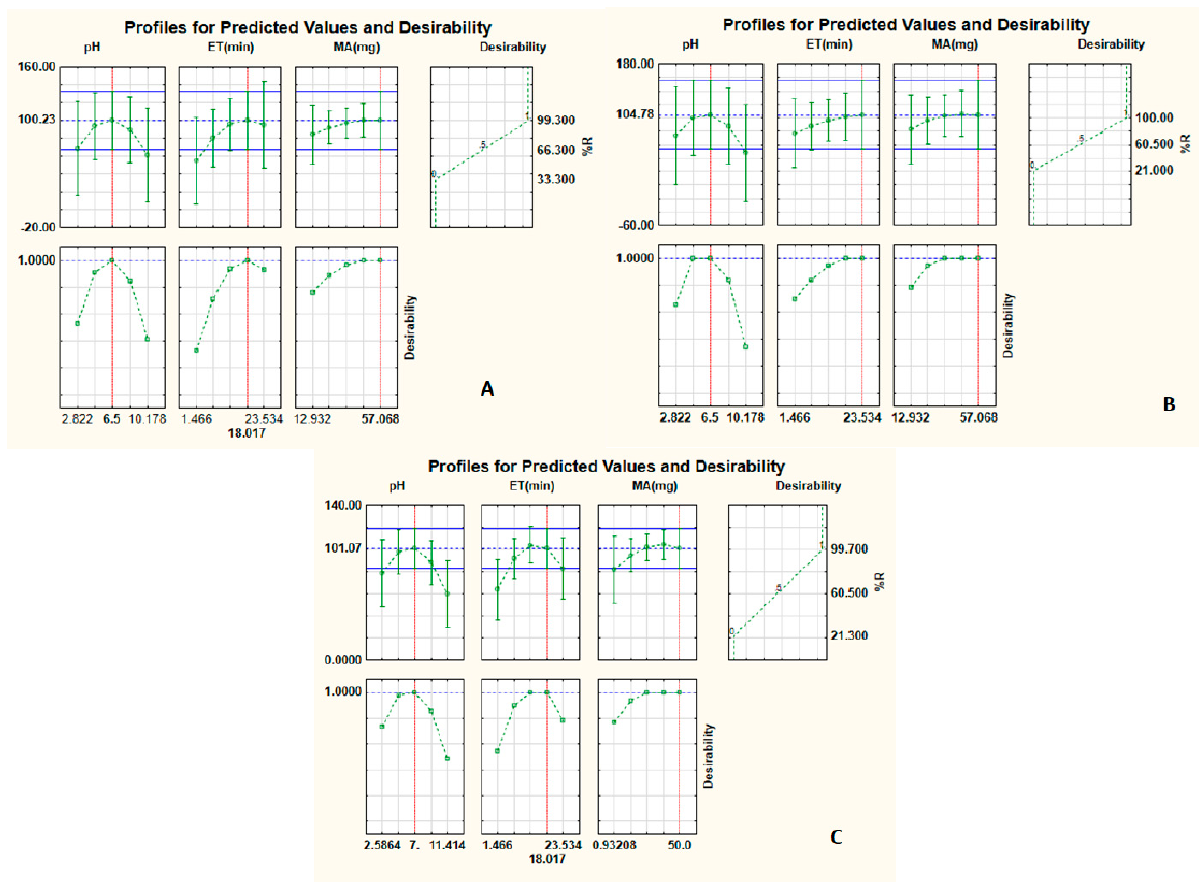
Figure 3. Desirability function for optimization of independent variables for ( A ) β -blockers and anticonvulsants, ( B ) fluoroquinolones and ( C ) parabens.